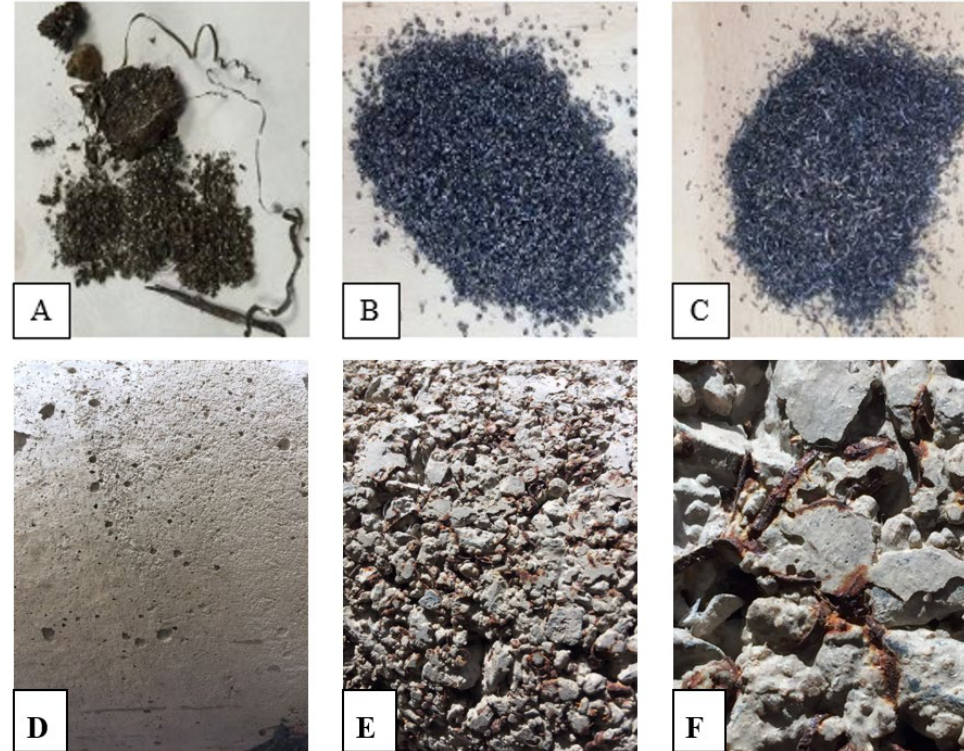
Figure 1. Recycled Steel Residuals in: ( A ) Raw Form, ( B ) Retained on No. 8 Sieve, ( C ) Passing through No. 8 Sieve, ( D ) Concrete without Rusting, ( E ) Concrete with RSR Rusting, and ( F ) Close up of Rusty RSR in Concrete.